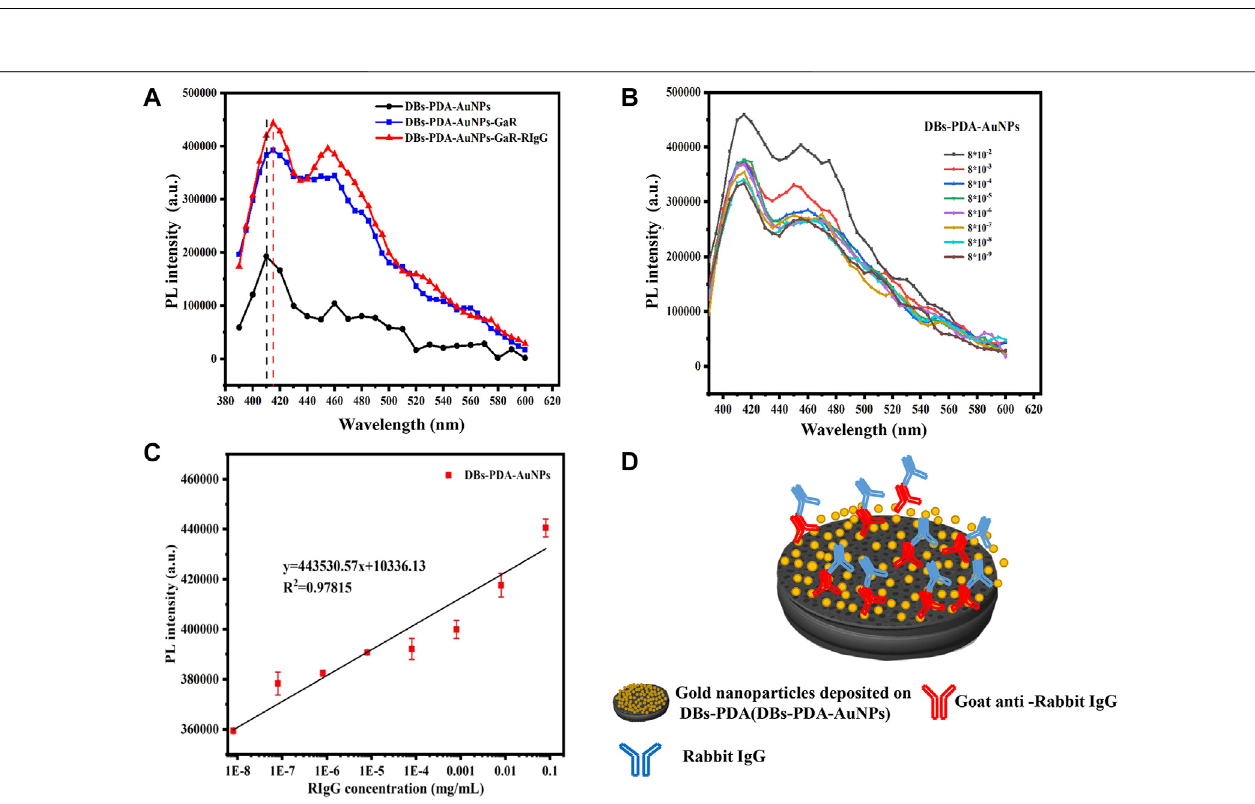
FIGURE 6 | (A) PL spectra of DBs-PDA-AuNPs, DBs-PDA-AuNPs-GaR, and DBs-PDA-AuNPs-GaR with its complimentary antigen (RIgG). (B) PL spectra showed DBs-PDA-AuNPs-GaR binding to different concentrations of RIgG (from 8 × 10 − 9 to 8 × 10 − 2 mg/ml). (C) PL intensity of DBs-PDA-AuNPs-GaR labeled with differentconcentrationsofRIgG(from8×10 − 9 to8×10 − 2 mg/ml)withacoef fi cientofdetermination ( R 2 )of0.97815.Excitationwavelengthwas360 nm. (D) Schemaof RIgG binding with